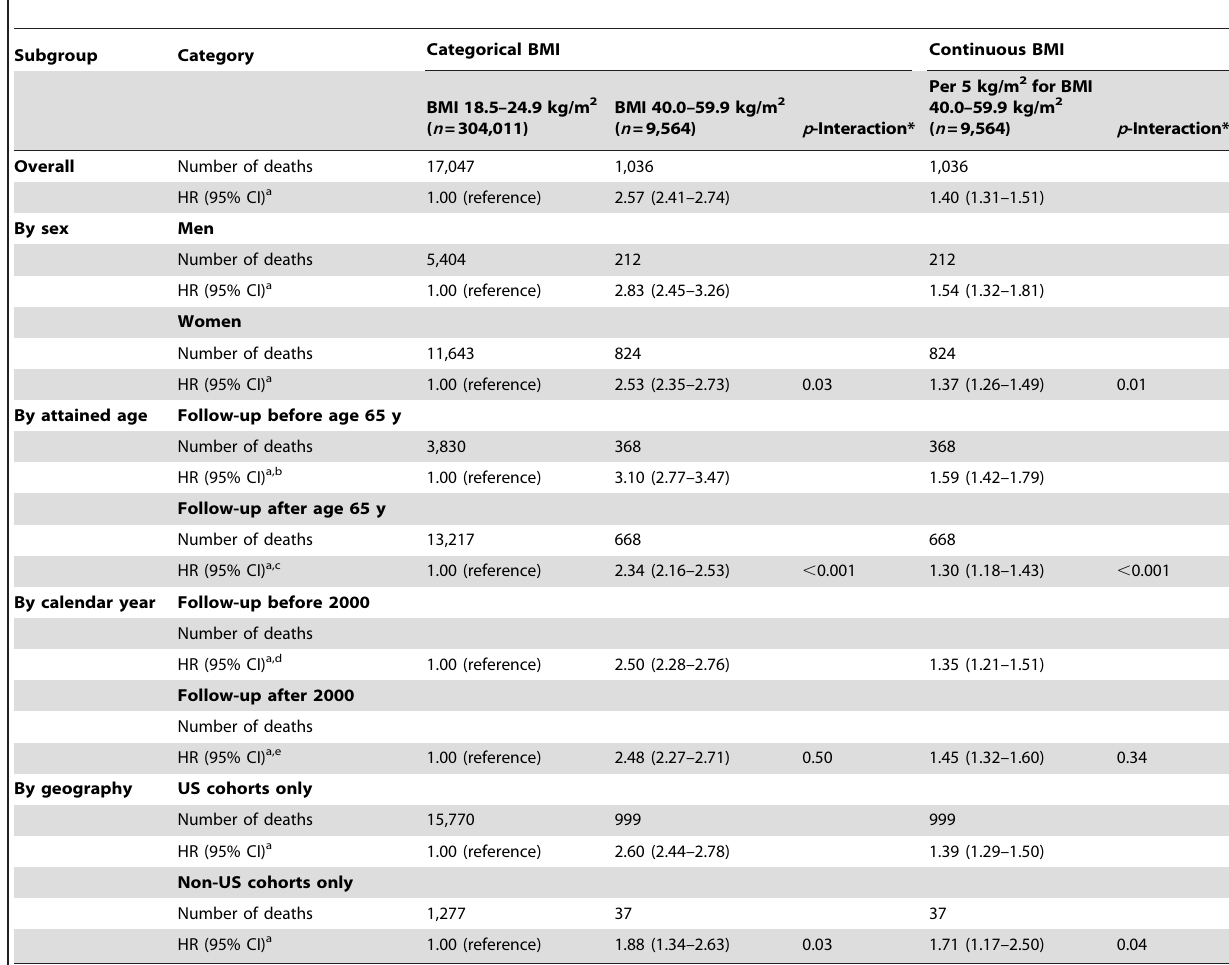
Table 5. Hazard ratios and 95% confidence intervals for risk of death according to BMI category (40.0–59.9 versus 18.5–24.9 kg/ m 2 ) or continuous values of BMI between 40.0 and 59.9 kg/m 2 (per 5 kg/m 2 ): subgroup